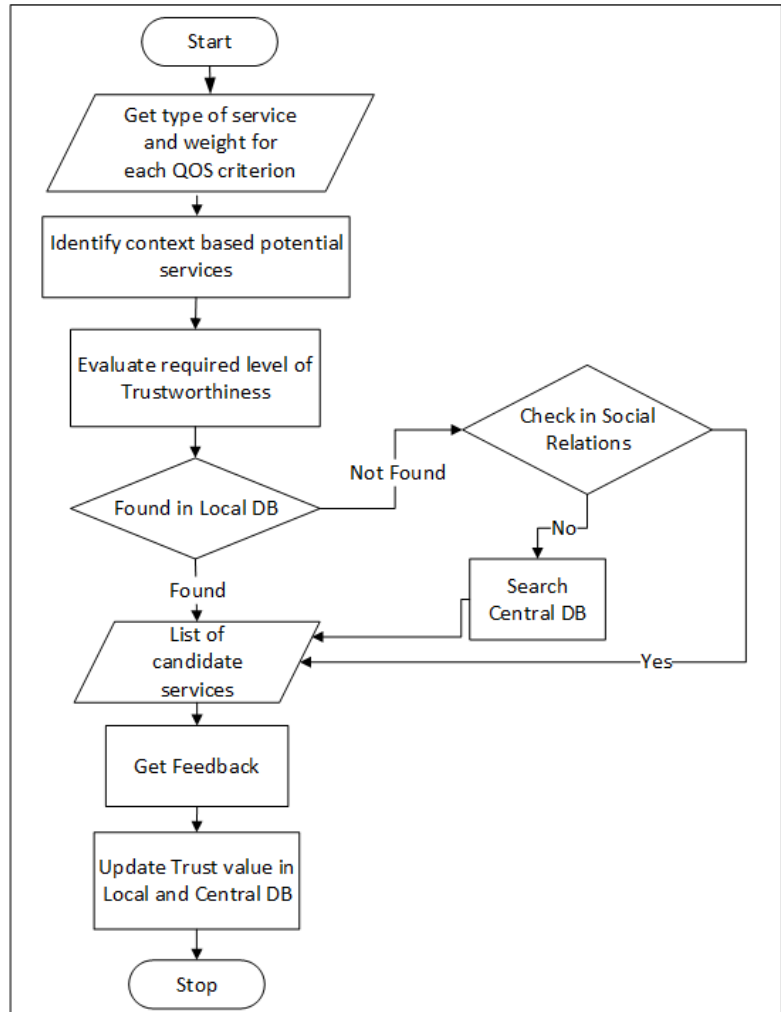
Figure 5. Flow chart summarizing the whole